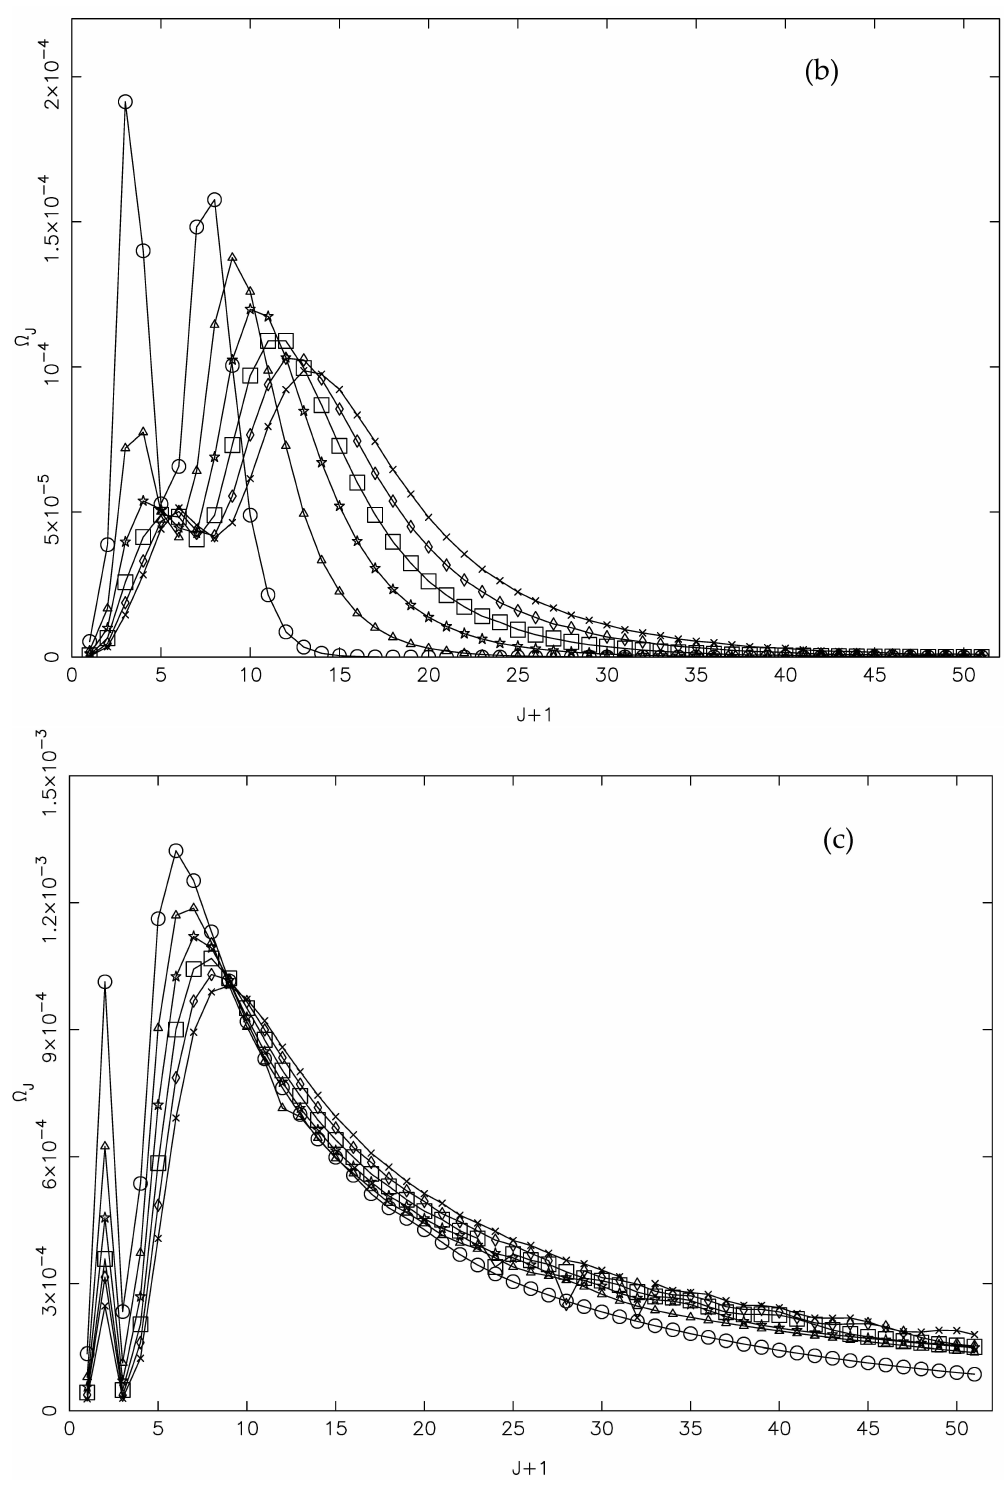
Figure 1. Partial collision strengths for the ( a ) 1–3 (2s 2 2p 5 2 P o